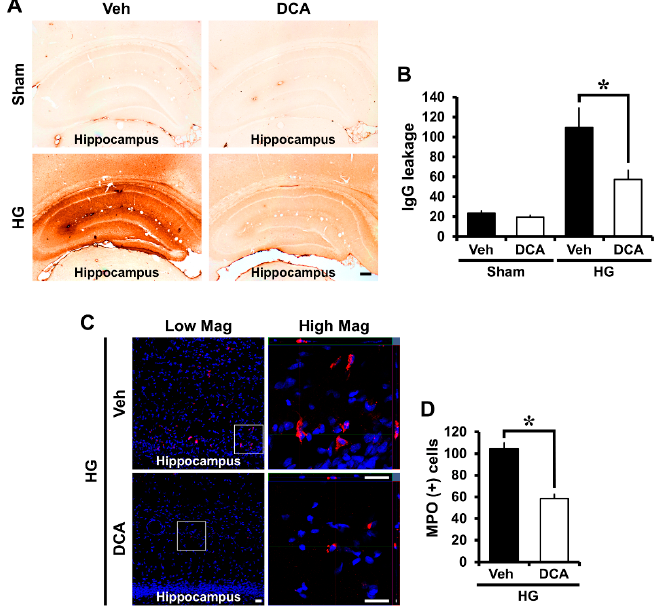
Figure 5. Administration of DCA decreases blood-brain barrier (BBB) breakdown and an influx of neutrophils after hypoglycemia. ( A ) Whereas sham-operated group had little leakage of IgG, the hypoglycemia group had a large quantity of IgG leakage when the BBB broke down. However, the DCA–treated group had significantly reduced IgG leakage. Scale bar = 200 µ m (4 × ). ( B ) The quantification of IgG leakage in the whole hippocampus. Data are mean ± S.E.M., n = 5 for each sham group, n = 8 for each hypoglycemia group. ( C ) Representative immunofluorescence images show expression of the neutrophil marker MPO in the cortex and hippocampus. DCA prevent Scale bar = 20 µ m. ( D ) The bar graph indicates the number of MPO ( + ) cells in the cortex and hippocampus. Data are mean ± S.E.M., n = 3 for each sham group and hypoglycemia group. * Significantly di ff erent from vehicle treated group, p <